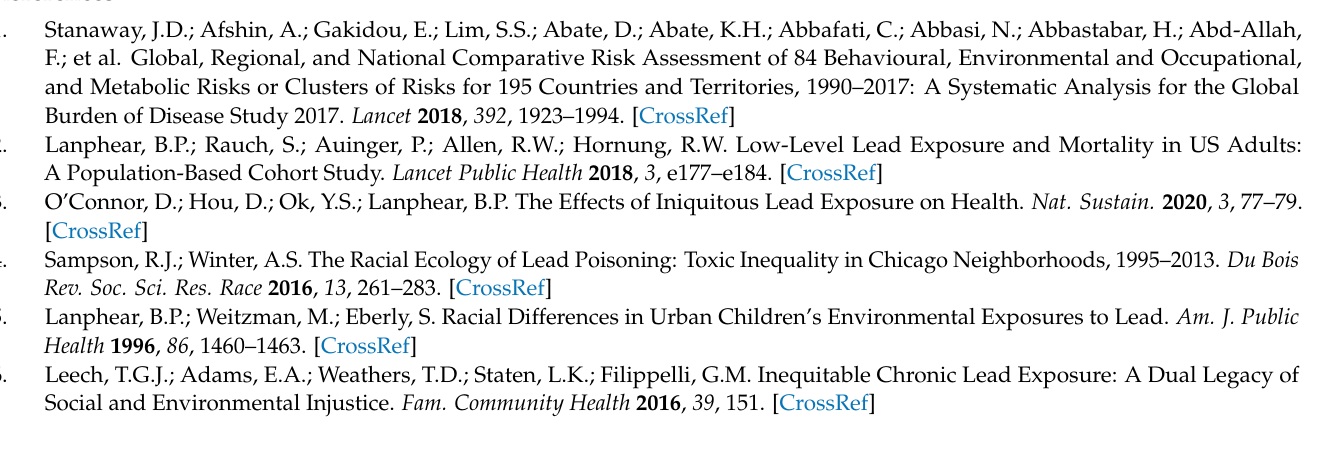
Table S2: The data file for the